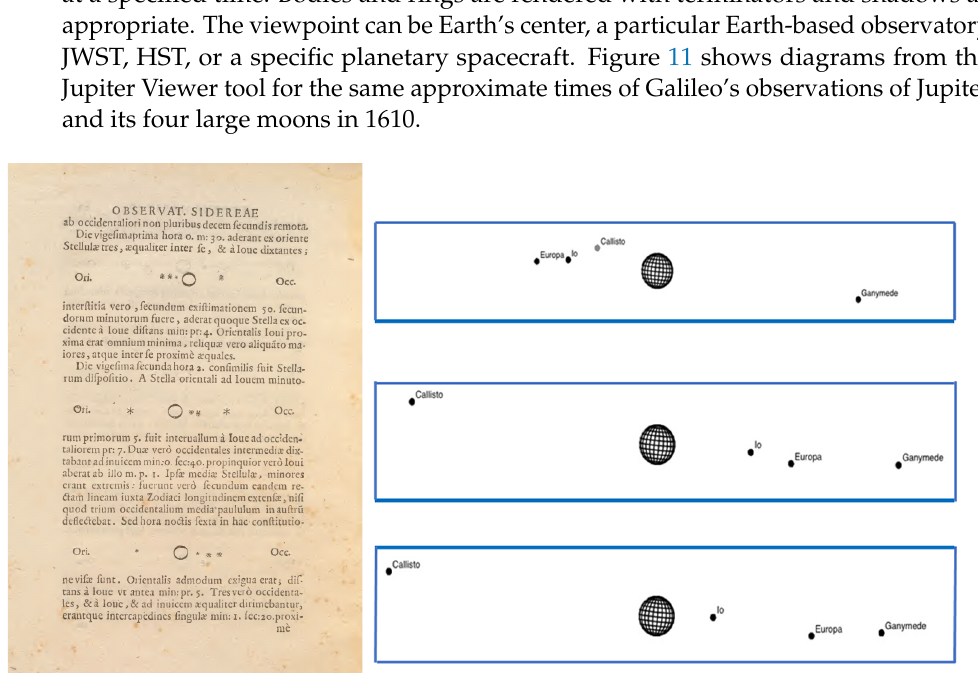
Figure 11. Galileo Galilei’s observations [47] on the nights of 21 and 22 January 1610 ( left ) and the corresponding diagrams from the RMS Node’s Jupiter Viewer tool ( right ) for the same approximate observing